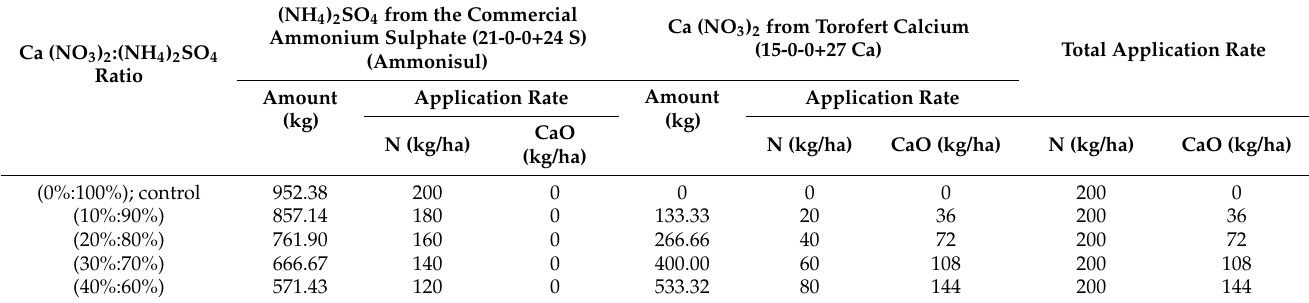
Table 2. Irrigation solution composition used in the